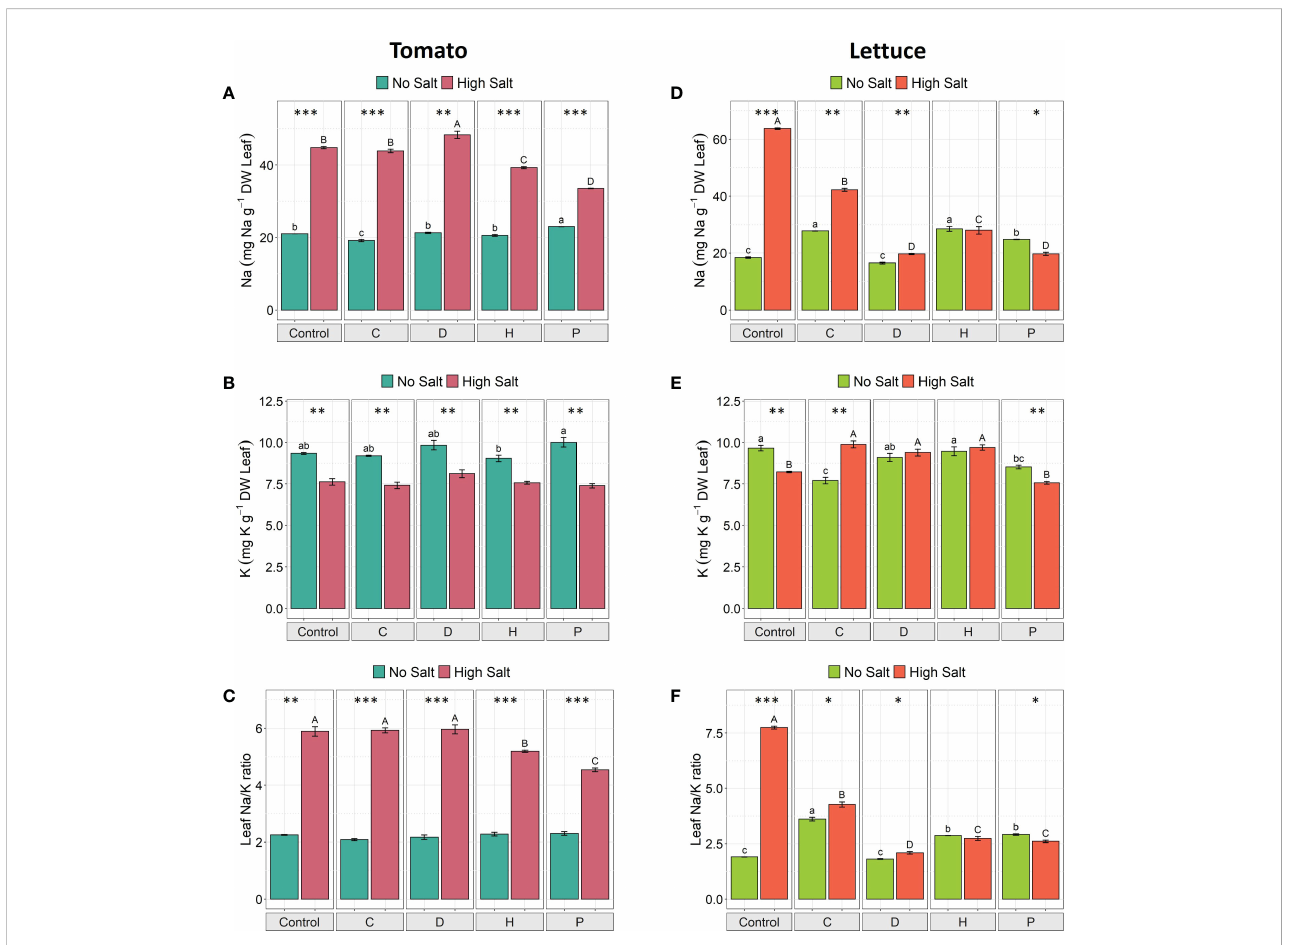
FIGURE 2 The concentration of Na + , K + and Na + /K + ratio in leaves of tomato (A – C) and lettuce (D – F) grown under salinity stress and protein hydrolysates application. Values are means ± SE. Lowercase letters compare treatments under no salt, and capital letters compare treatments under high salt. Equal letters correspond to average values that do not differ according to Tukey ’ s HSD test (p < 0.05). Asterisks indicate signi fi cant differences between high and no salt, according to Student ’ s t- test (*p < 0.05, **p < 0.01, ***p < 0.001).